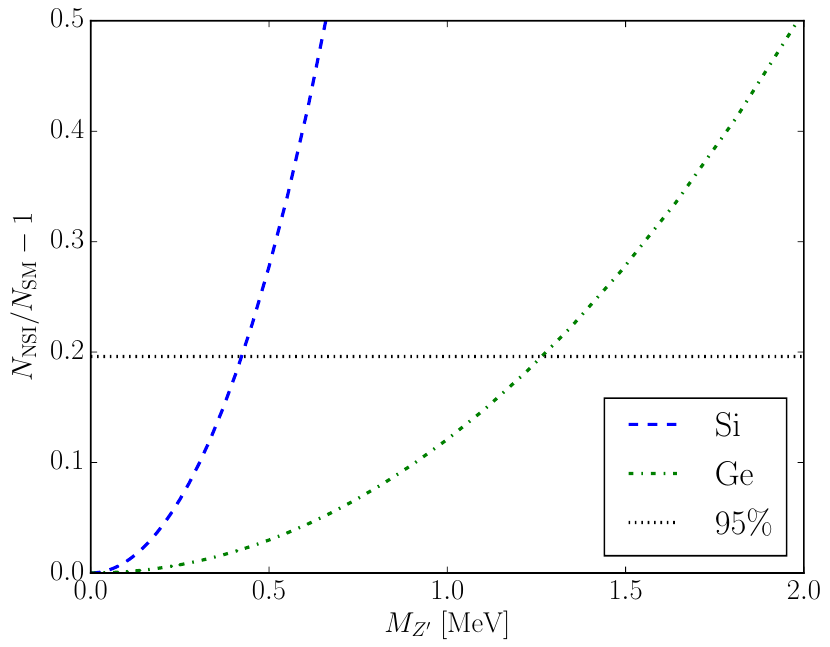
Figure 6 . The deviation of the prediction of the LMA-Dark solution with mediator of mass M Z 0 from that of SM in a reactor neutrino setup such as CONUS. The Si and Ge detectors are taken to have recoil energy thresholds of 0 : 1 keV and 0 : 6 keV respectively. The horizontal dotted line shows the 95% C.L. bound, assuming 10 5 events in case of the SM and constrains M Z 0 < 0 : 45 MeV (1 : 3 MeV) with Si (Ge) detectors respectively. Bounds from BBN and the